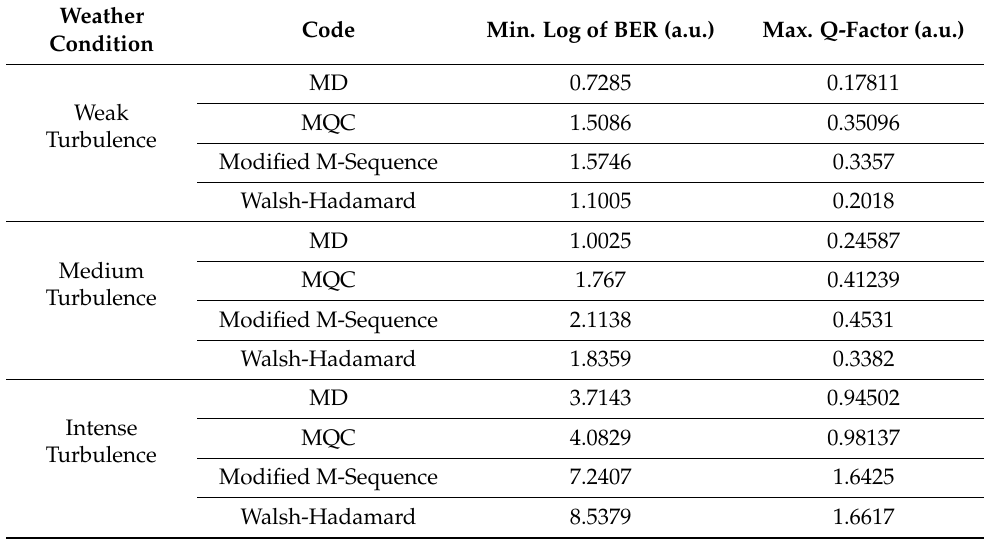
Table 7. Performance degradation with the increasing of FSO range in different turbulence